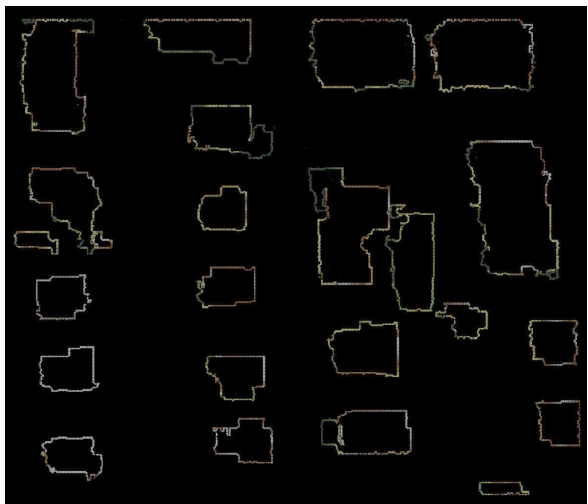
Figure 3: Roof outline extent after eliminating the wrong